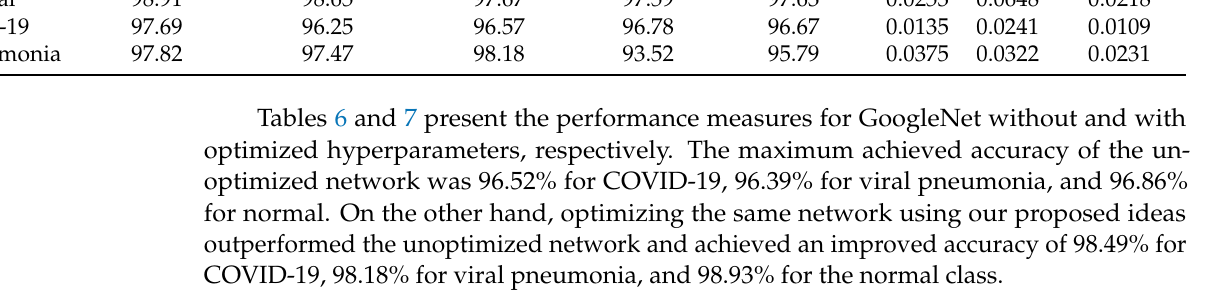
Table 6. Performance measures for GoogleNet without optimization for X-ray images.